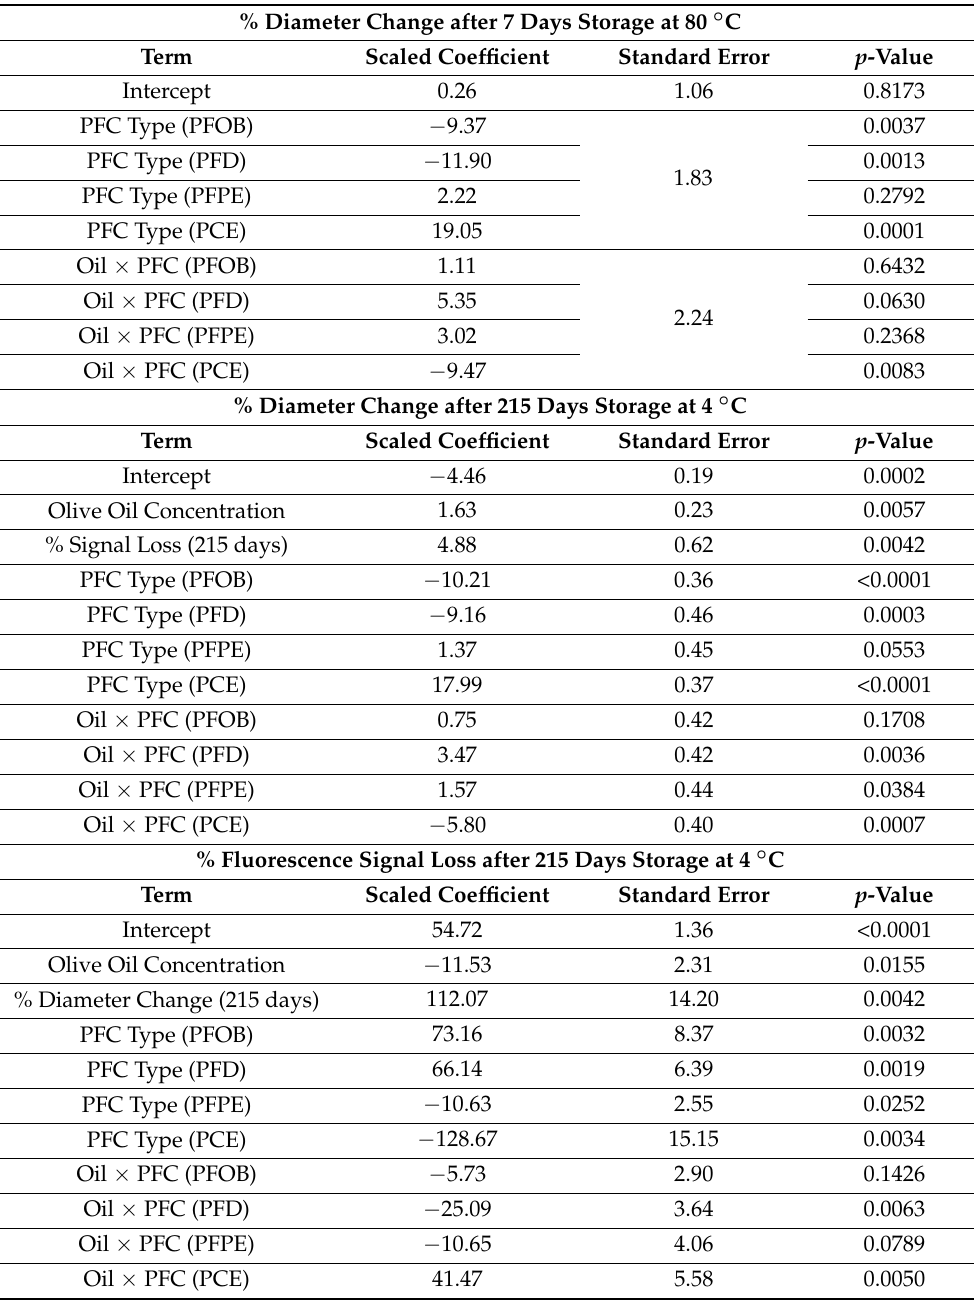
Table 7. Parameter scaled coefficients, standard errors, and p -values for MLR models developed to predict nanoemulsion percent diameter change after 7 days incubation at 80 ◦ C (top), nanoemul- sion percent diameter change after 215 days storage at 4 ◦ C (middle), and nanoemulsion percent fluorescence signal loss after 215 days storage at 4 ◦ C